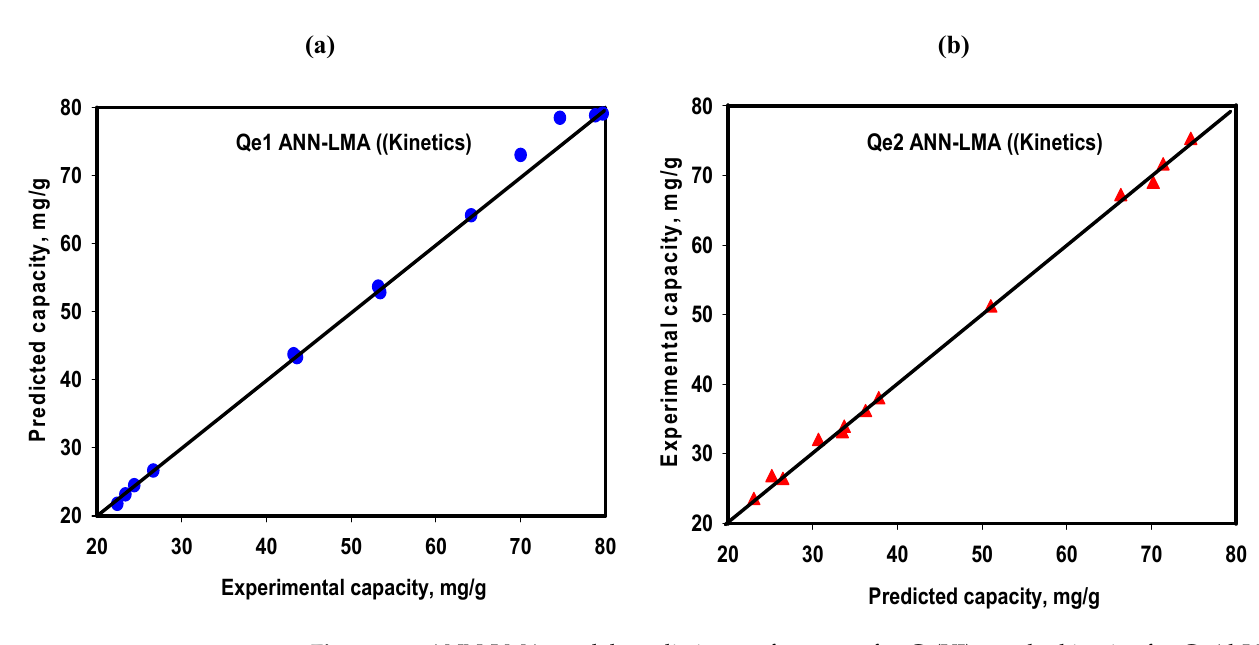
Figure 12. ANN-LMA model predictive performance for Cr(VI) uptake kinetics for CoAl-LDH ( a ) and bentonite-CoAl-LDH ( b ). Table 10. Non-linear kinetic model fitting parameters for CoAl-LDH and bentonite-CoAl-LDH for Cr(VI)